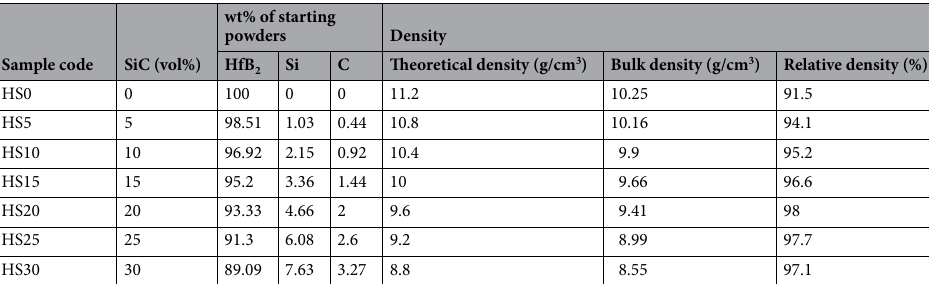
Table 3. Characterizations and sintering conditions of in situ HfB 2 -SiC composites sintered at 2050 °C for 4 h.